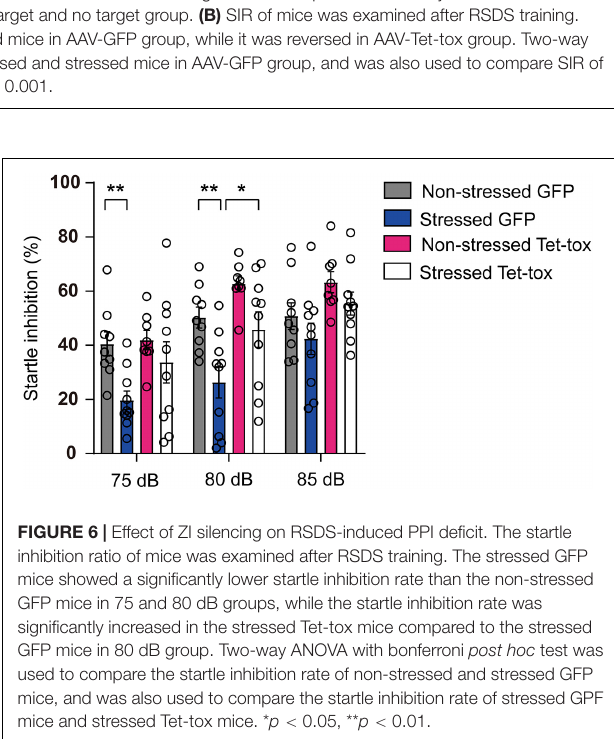
stressed mice in AAV-GFP group ( p = 0.006); bonferroni post hoc